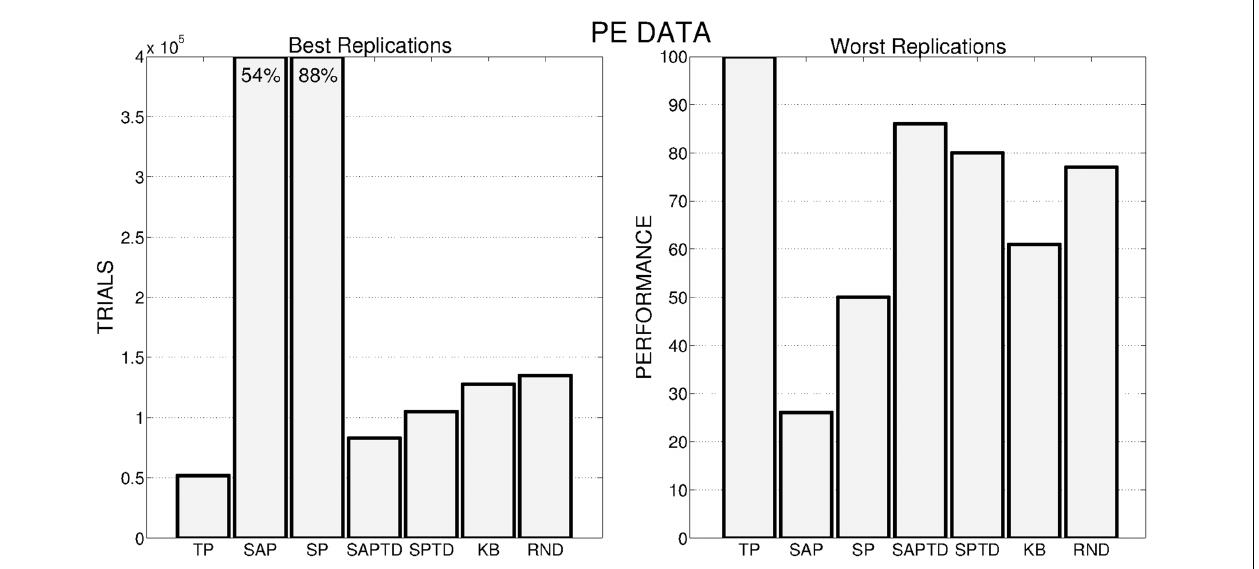
FIGURE 6 | Left: Number of trials needed by the best replication of each condition to achieve the target performance. When the target value is not achieved within the time limit, the final